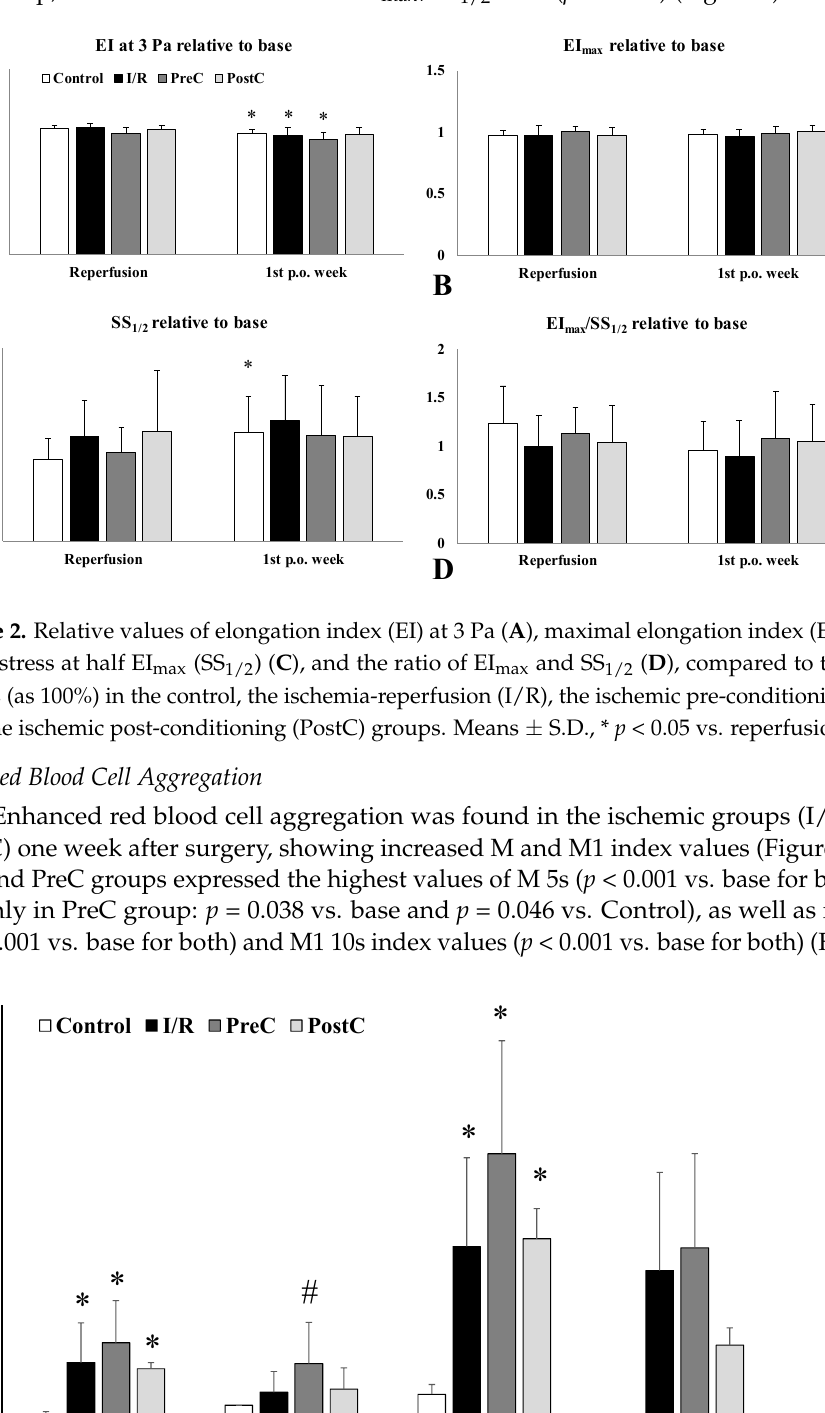
Figure 3. Red blood cell aggregation index values (M 5s, M1 5s, M 10s, M1 10s) in the control, the ischemia-reperfusion (I/R), the ischemic pre-conditioning (PreC), and the ischemic post-conditioning (PostC) groups on the first postoperative week. Means ± S.D., * p < 0.05 vs. Control group and # p < 0.05 vs. I/R group (same time).